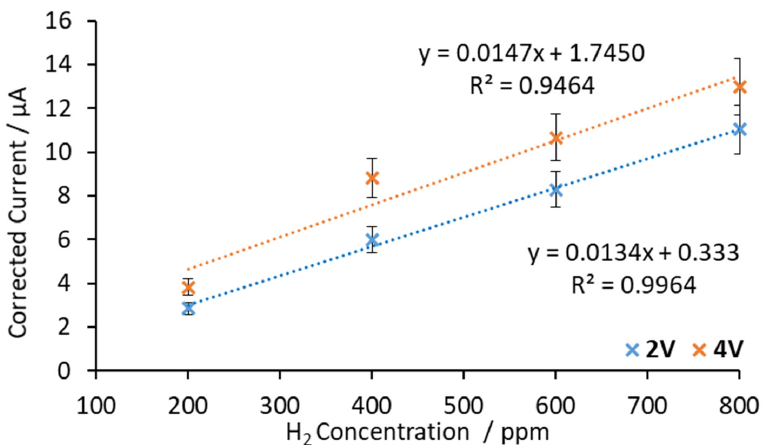
Figure 6. Calibration curves obtained with SrCeZrYb at 500 °C by applying 2 V and 4 V between the electrodes.